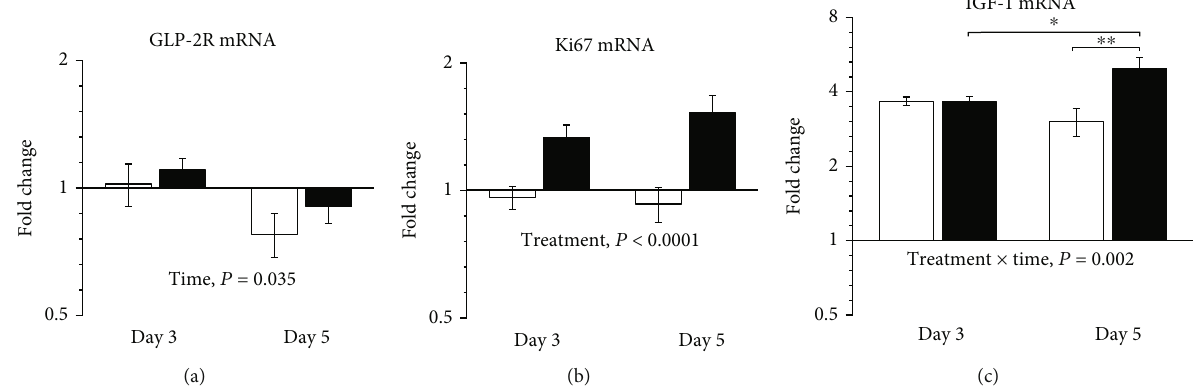
Figure 3: GLP-2R (a), Ki67 (b), and IGF-1 (c) mRNA levels in anastomotic wounds on days 3 and 5 normalized to RPLP0 and shown as fold changes relative to the noninjured colon of vehicle-treated rats on day 0. Open bars: vehicle; fi lled bars: ZP1849. ∗ P < 0 : 05 and ∗∗ P < 0 : 01 . Geometric mean ± back ‐ transformed